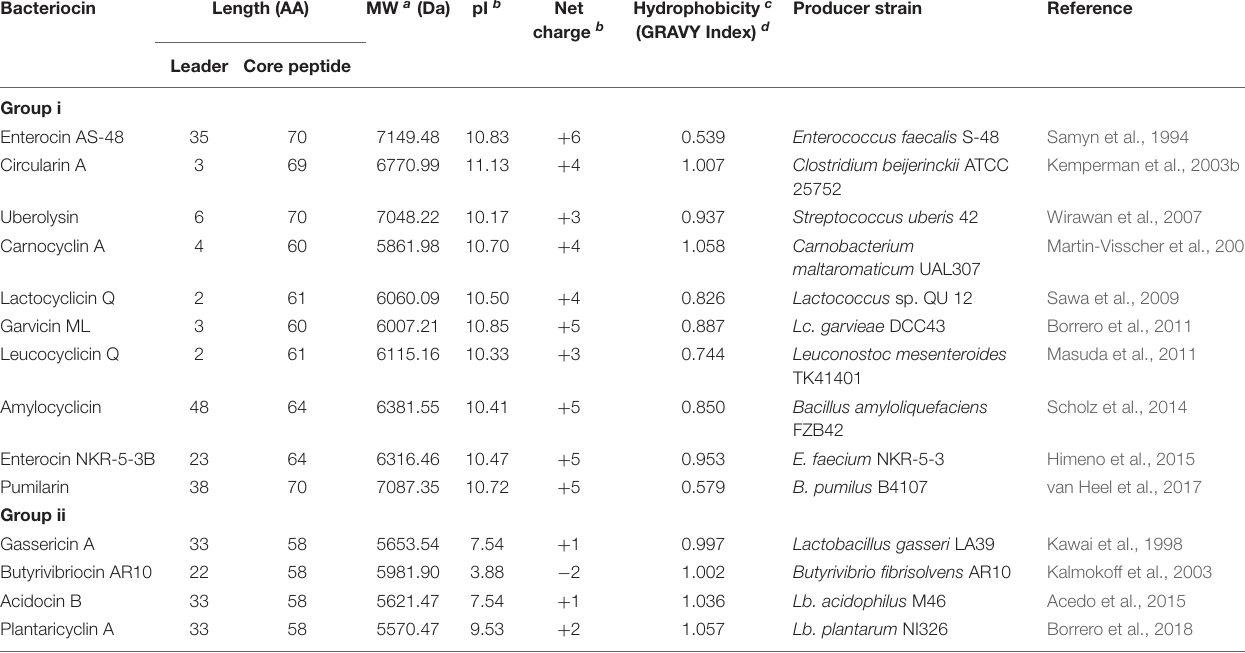
TABLE 1 | Relevant characteristics of circular